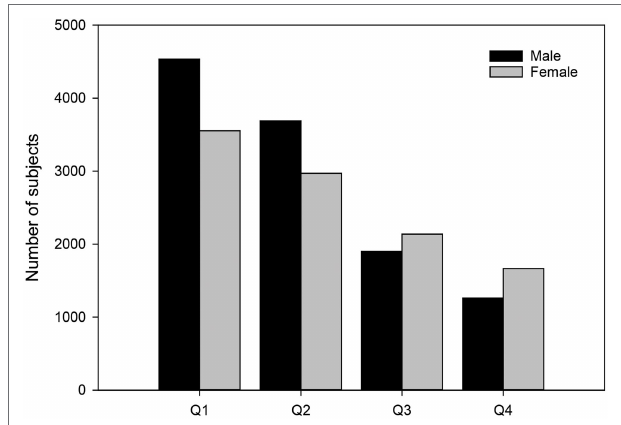
FIGURE 1 | Quarterly birth distribution for males and females in the entire sample ( N = 21,711). Q1 = Jan–March, Q2 = April–June, Q3 = July–Sept, Q4 = Oct–Dec. The number of subjects decreases significantly from Q1 to Q4 for both males ɸ = 0.44, p < 0.05, Large RAE and females ɸ = 0.26, Medium RAE, p <